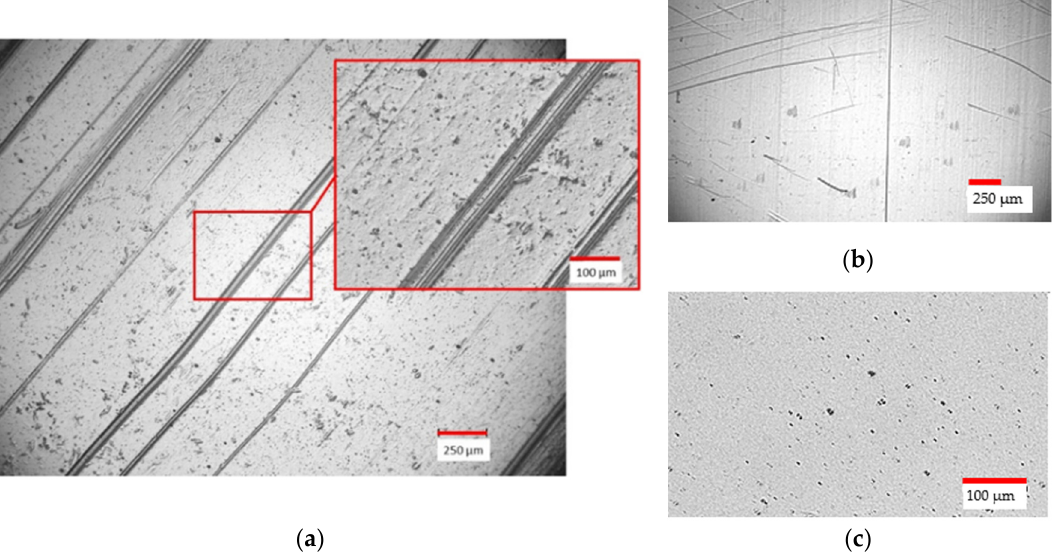
Figure 11. Irregularities found on the CA membrane surfaces after coating and drying. A pattern of defects with a close-up ( a ). In hindsight, the defects were also found on the non-coated PES carrier ( b ), but, as a consequence, the CA membrane, without visible defects, could be produced ( c ).